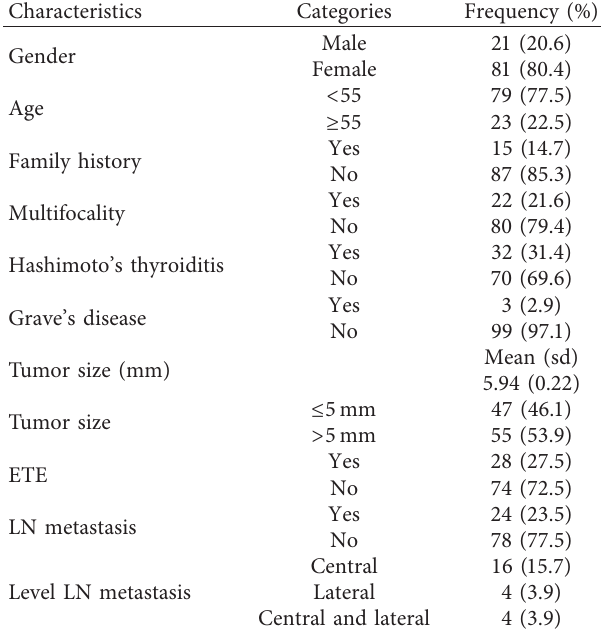
Table 1: Patient and disease characteristics.